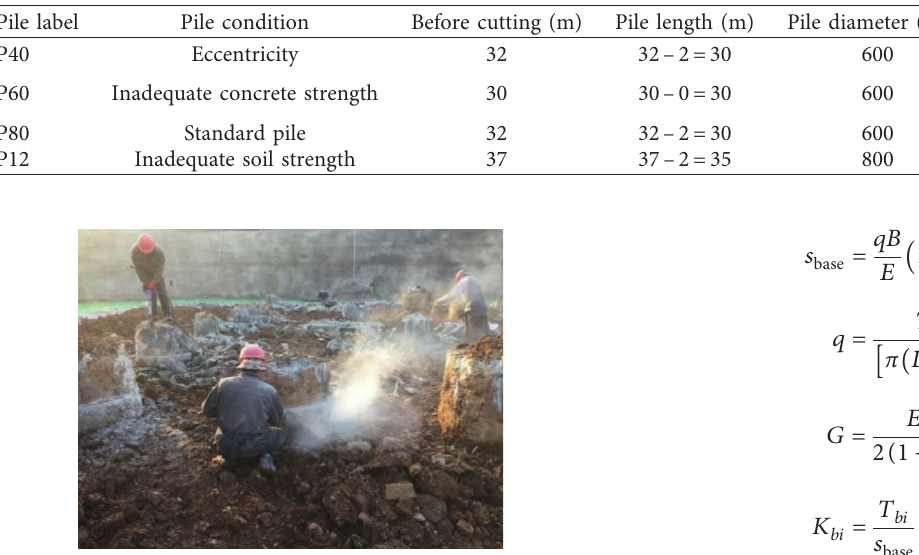
Figure 4: Percussion of pile